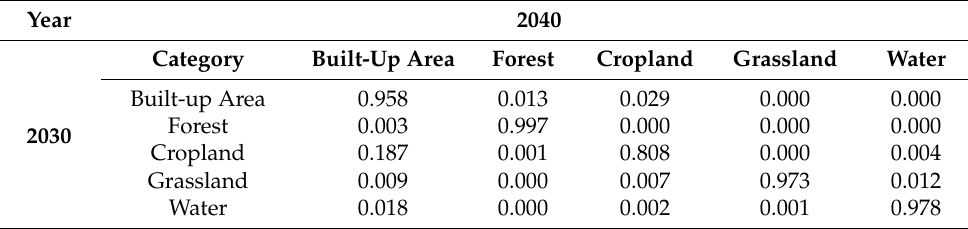
Table 11. Transition Matrix from